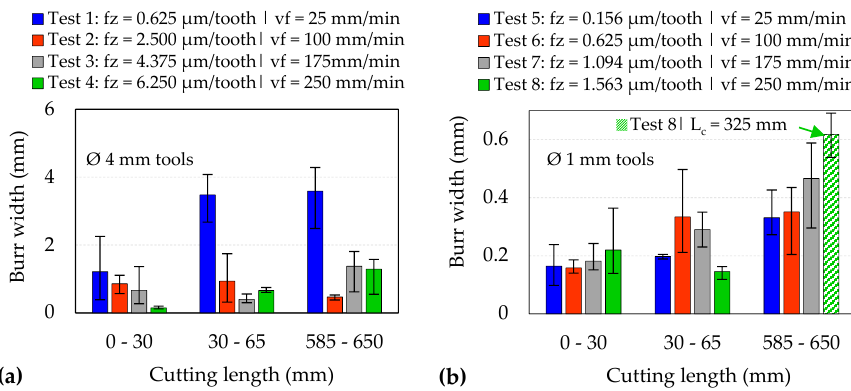
Figure 17. Average burr width for slots machined using ( a ) Ø 4 mm and ( b ) Ø 1 mm end-mills.